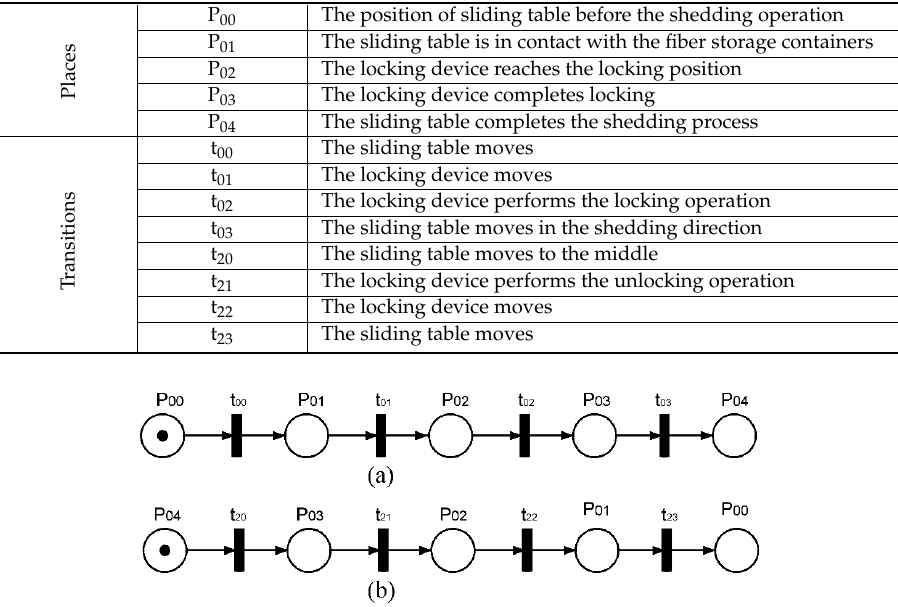
Table 1. Table of places and transitions in the shedding process and closing the shed.